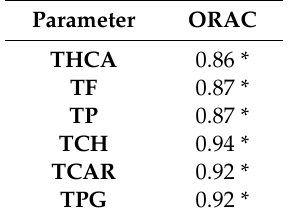
Table 6. Pearson’s correlations between nettle leaves polyphenols (mg 100 g − 1 dm),